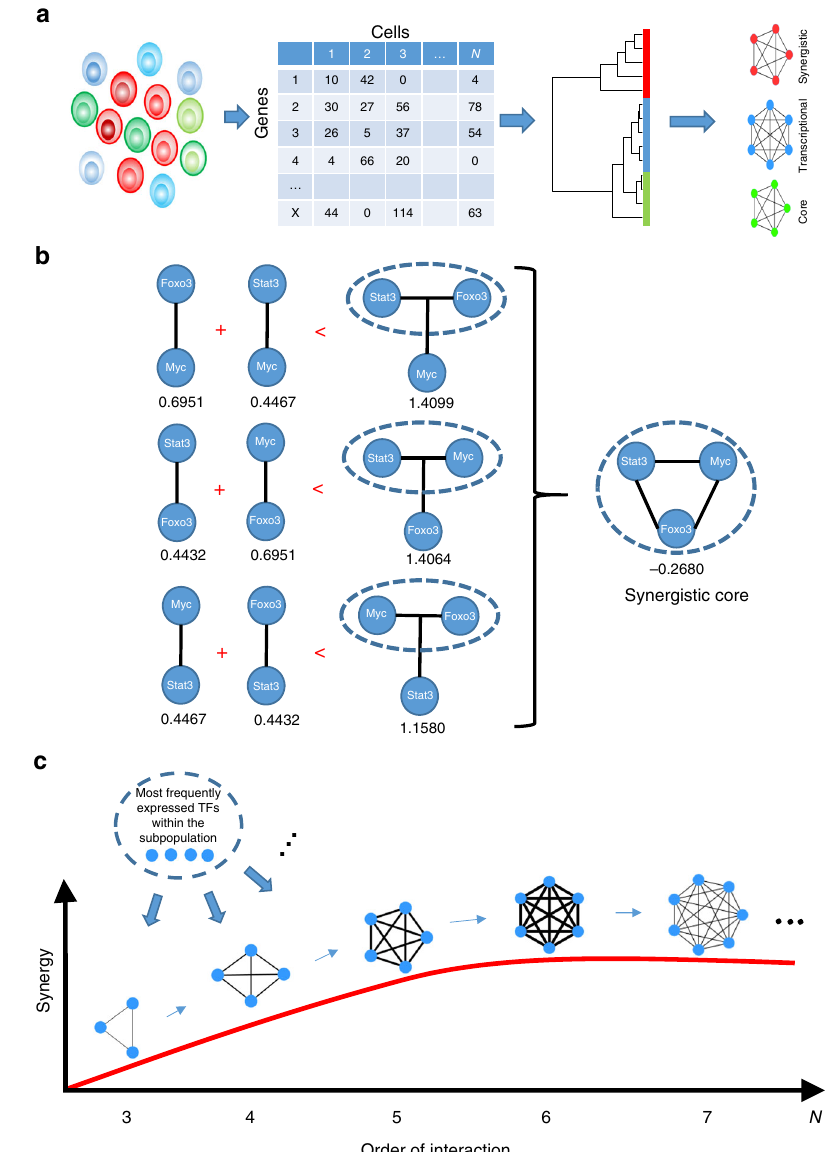
Fig. 1 Principle of transcriptional synergy and method overview. a The method requires single-cell RNA-seq data classi fi ed into distinct subpopulations as input and identi fi es most synergistic transcriptional cores for each subpopulation. b Comparison of pair-wise MI between individual TF pairs with joint MI between two TFs together and a third one. For a combination of TFs to be synergistic, the sum of pair-wise MIs has to be less than the joint MI (i.e., negative MMI). Any permutation of same set of TFs results in the same MMI value. c Dynamic search for identifying the most synergistic transcriptional cores, in which the “ seed ” 3-TF combinations are progressively expanded by an addition of another TF one by one. The search is terminated when there is no more increase in synergy when adding a new TF to the current best combination and the current combination is considered the most